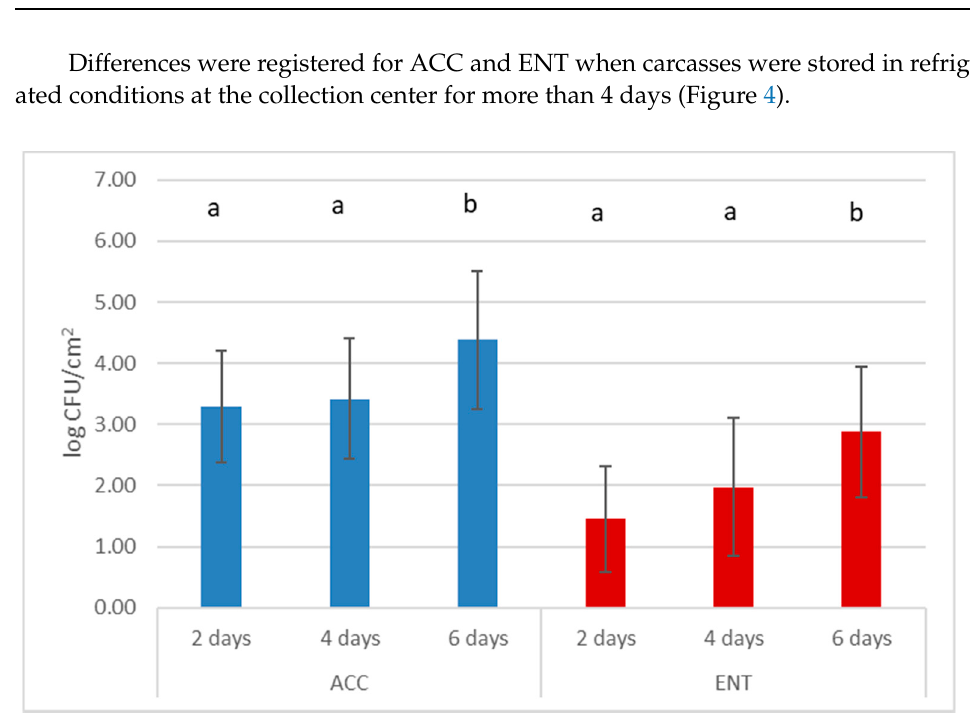
Figure 4. Mean values and standard deviation (bars) of aerobic colony count (ACC) and Enterobacte- riaceae count (ENT) relative to storage time in collection center; n = 120. Different superscript letters for factors indicate statistically different mean values ( p < 0.05).